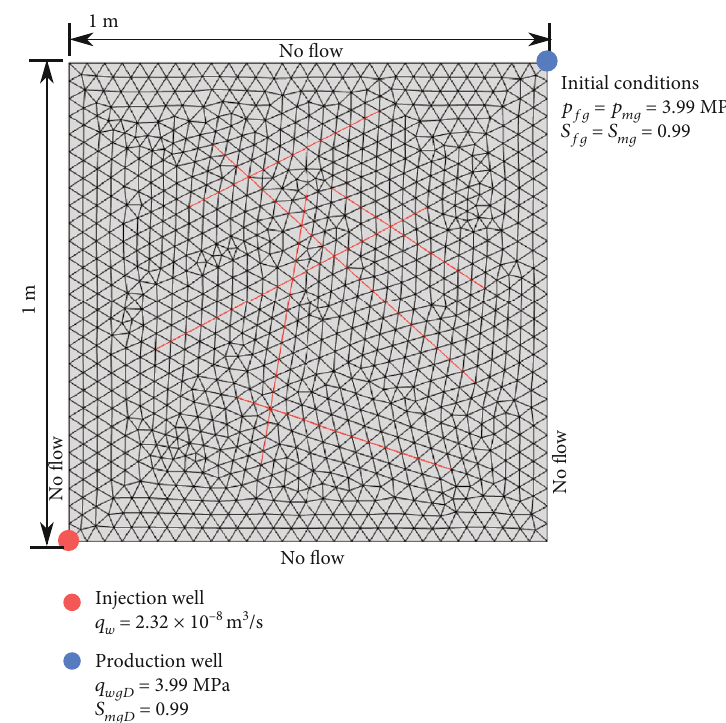
Figure 2: Scheme depicting geometry, mesh boundary, and initial conditions of the simulation model.